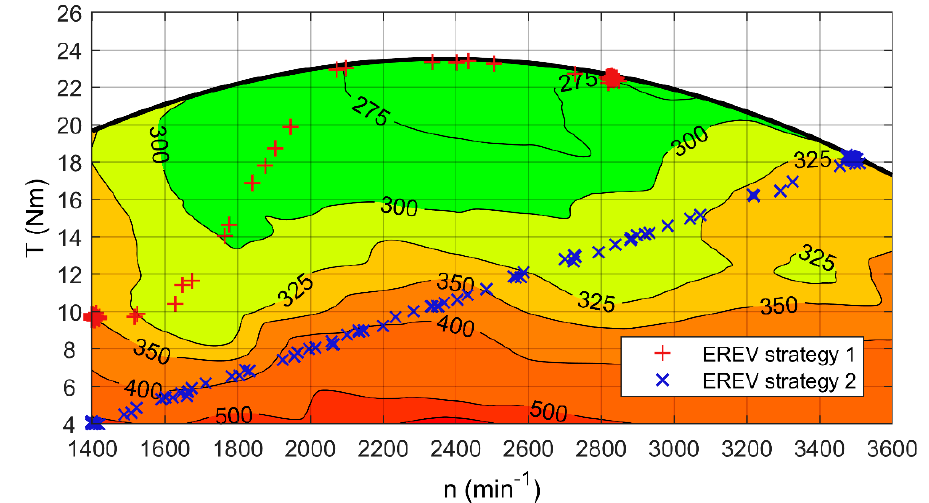
Figure 13. LPG-supplied range extender operation points for two simulated control strategies plotted onto the map of BSFC.